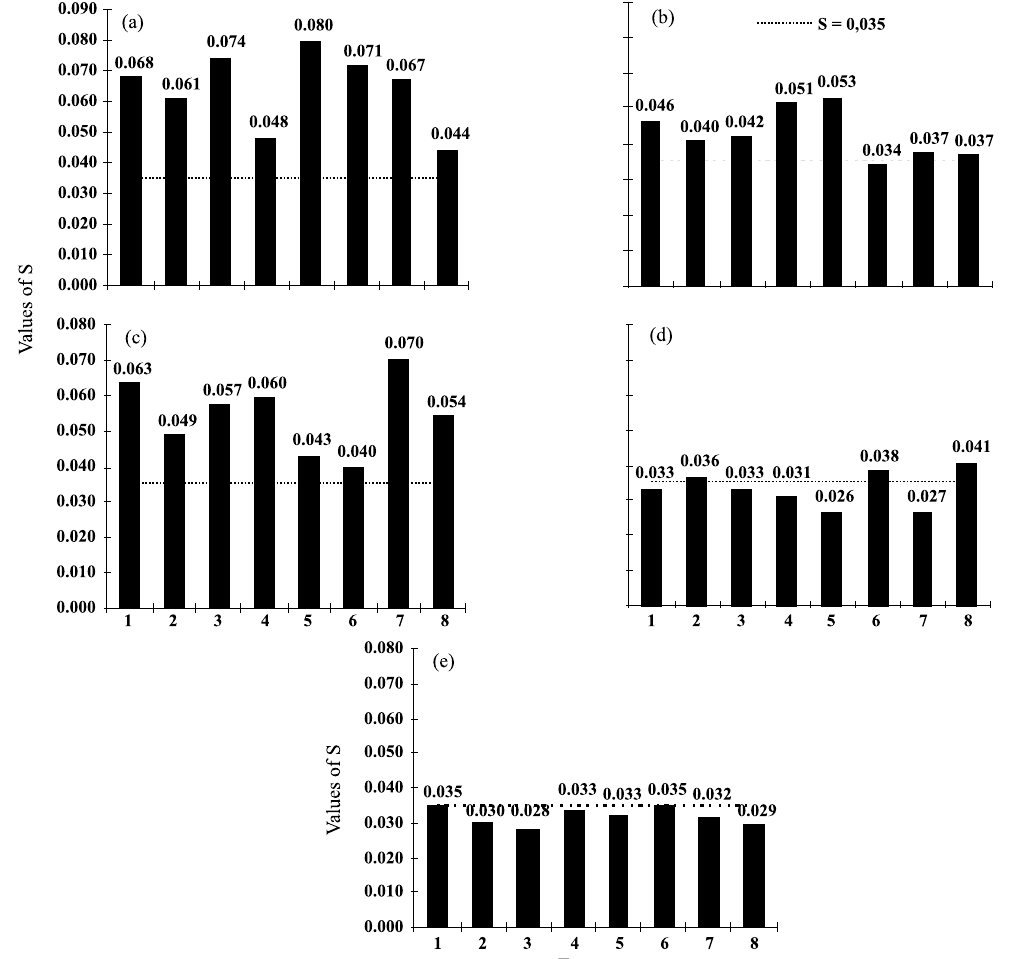
Figure 5. S values observed after cover crop desiccation in the third year of the experiment (2005/2006) as affected by soil depth. (a) 0–0.05 m; (b) 0.075–0.125 m; (c) 0.15–0.20 m; (d) 0.275–0.325 m and (e) 0.475– 0.525 m. Treatments: 1) sunflower + pearl millet; 2) sunflower + sorghum; 3) sunflower + sunn hemp; 4) sunflower + chiseling; 5) triticale + pearl millet; 6) triticale + sorghum; 7) triticale + sunn hemp and 8) Triticale +